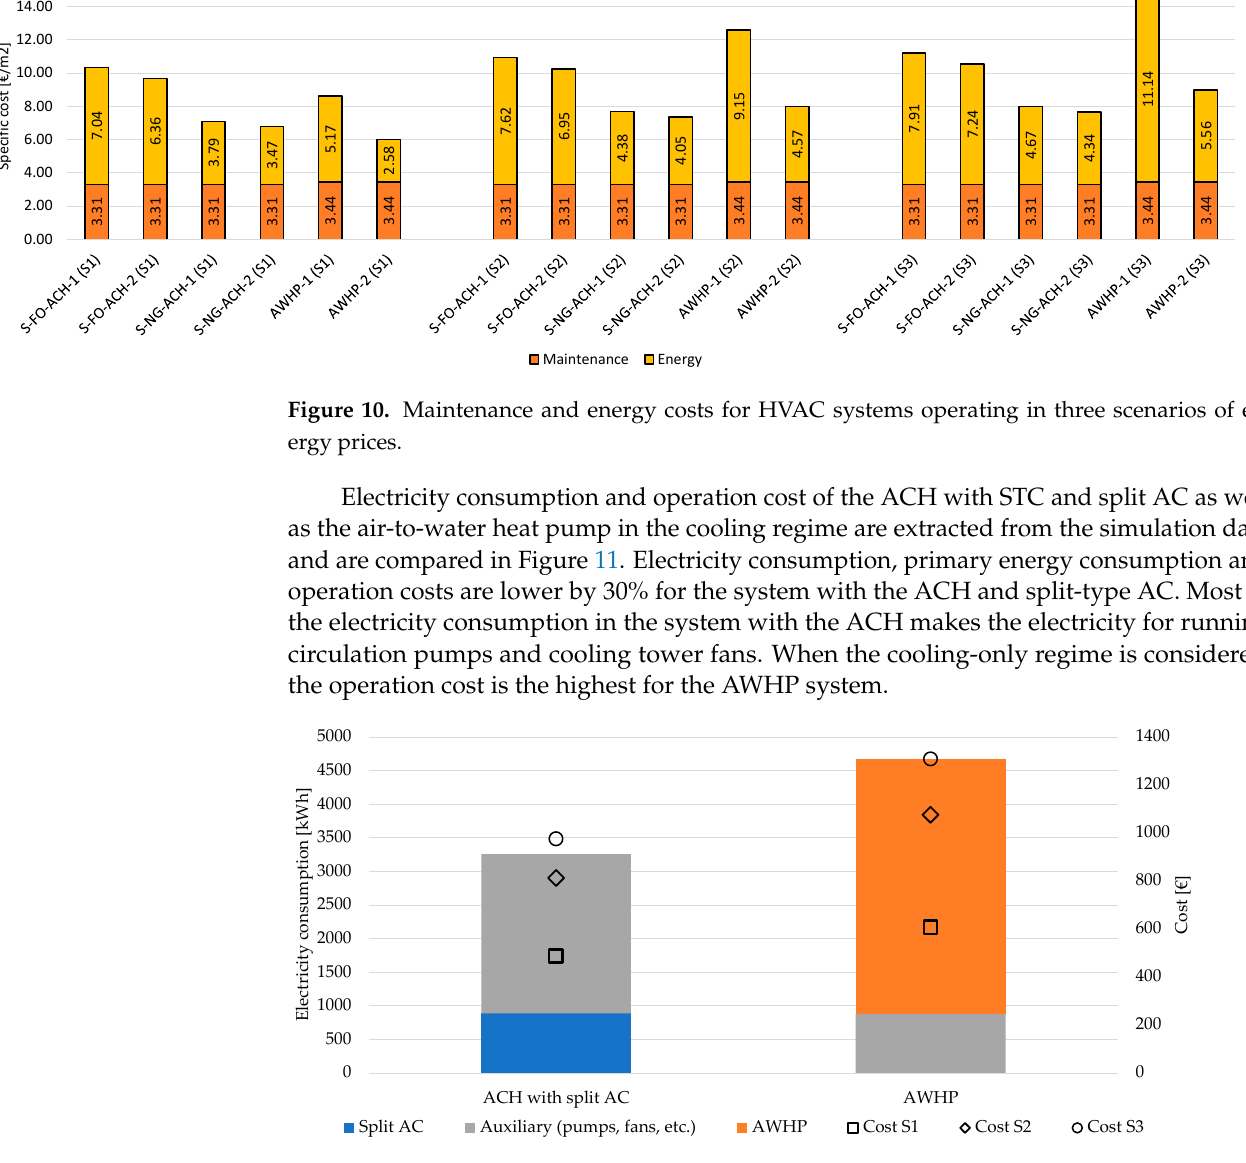
Figure 9. Results of global cost and primary energy consumption from simulations for HVAC sys- tems in three scenarios of energy prices (S1, S2, S3).